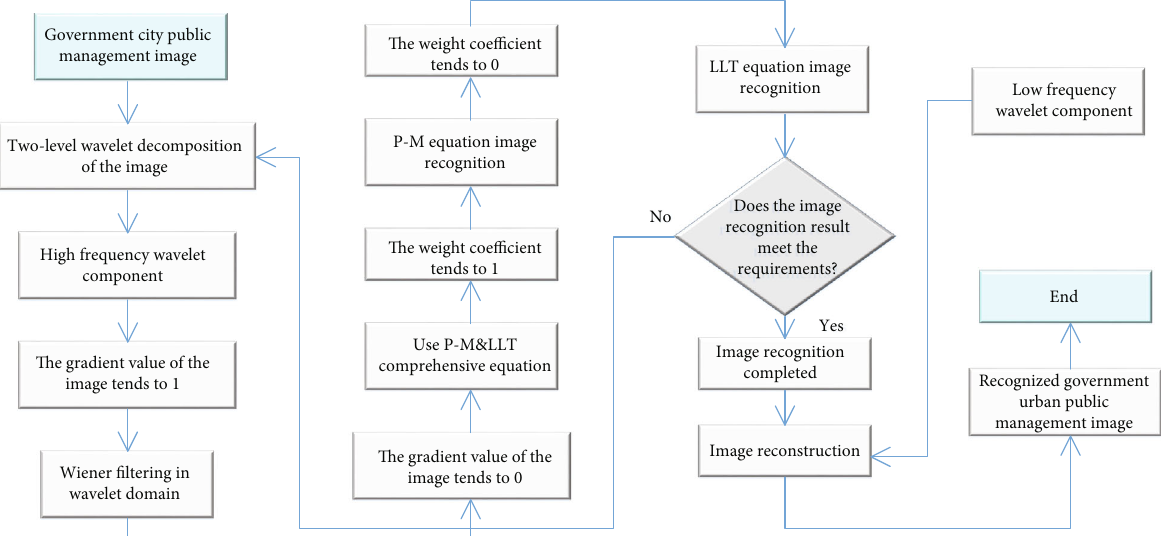
Figure 3: The algorithm fl ow chart of the mathematical model combining wavelet and partial di ff erential equations.